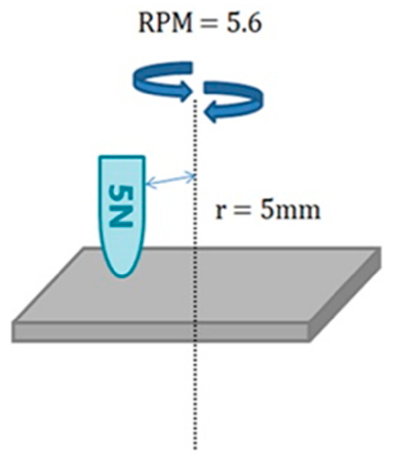
Figure 9. Conditions set for the tribometer.